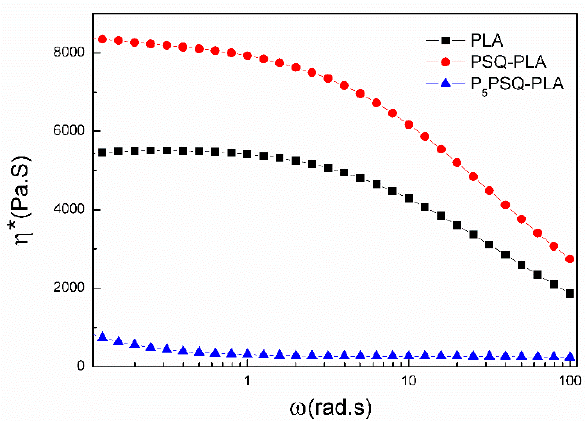
Figure 8. Complex viscosity of PLA and its flame retardant composites.